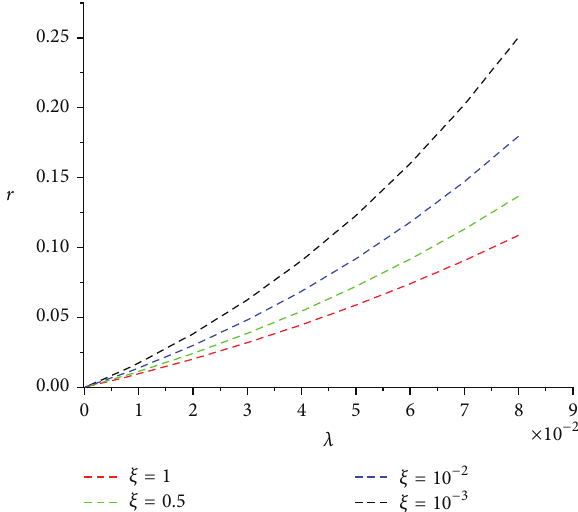
Figure 6: 𝑑𝑛 𝑠 /𝑑 ln (𝑘) versus 𝜆 for different values of 𝜉 for 𝑇 = 5 × 10 58 GeV 4 and 𝑁 = 60